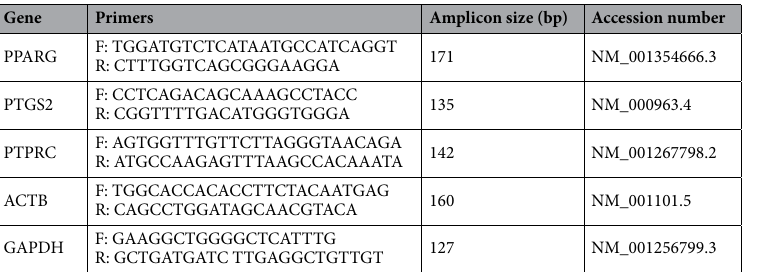
Table 4. Gene names, primer sequences, amplicon sizes, and accession numbers of analyzed genes. PPARG peroxisome proliferator activated receptor gamma, PTGS2 prostaglandin-endoperoxide synthase 2, PTPRC Protein tyrosine phosphatase receptor type C, ACTB actin beta, GAPDH glyceraldehyde-3-phosphate dehydrogenase, F forward, R reverse, bp base